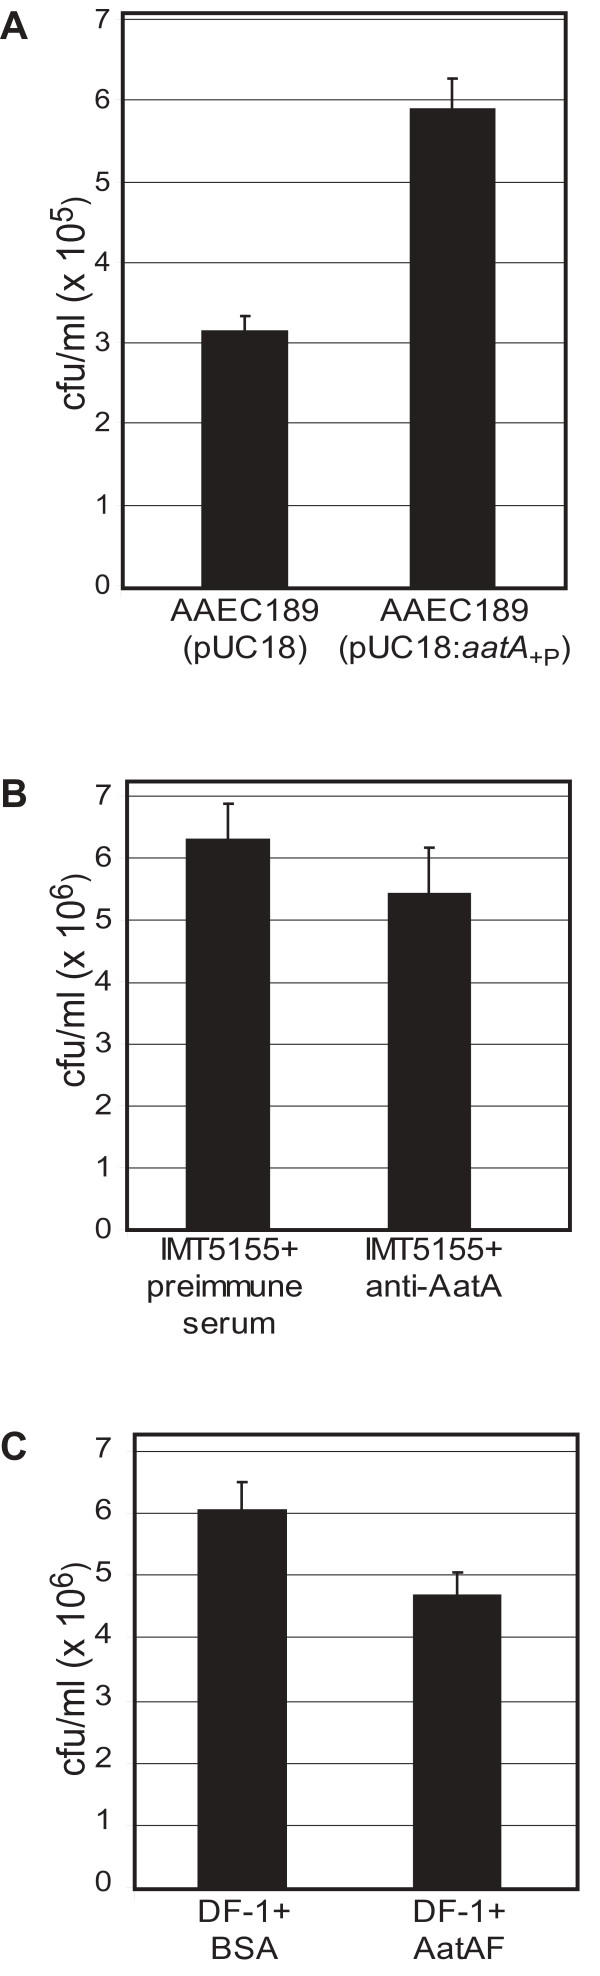
AatA plays a role in adhesion to chicken fibroblast DF-1 cells. A: Adhesion of AAEC189(pUC18) and AAEC189(pUC18:aatA+P), expressing aatA under its native promoter, to DF-1 cells. Monolayers of DF-1 cells were incubated with E. coli strains for 3 h at 37°C. Adherent bacterial cells were harvested and the number was determined. B: The anti-AatA antibody inhibits binding capacity of IMT5155 to DF-1 cells. IMT5155 was incubated with preimmune serum (control) and with anti-AatA antibody, respectively. After washing, bacteria of each experiment were added to monolayers of DF-1 cells and incubated for 3 hours. Adherent bacterial cells were harvested and the number was determined. C: Pre-incubation of DF-1 cells with AatAF protein reduces adhesion capacity of IMT5155 to these cells. Confluent monolayers of DF-1 cells were incubated with BSA (control, 50 μg/well) or purified and refolded AatAF protein (50 μg/well) for 1 h at 37°C prior to the addition of IMT5155 cells. After 3 h of incubation, adherent bacterial cells were harvested and the number was determined. A-C: Columns represent the mean value of three independent wells per strain. Standard errors of the mean values are indicated as error bars. The experiment was repeated three times showing comparable results.